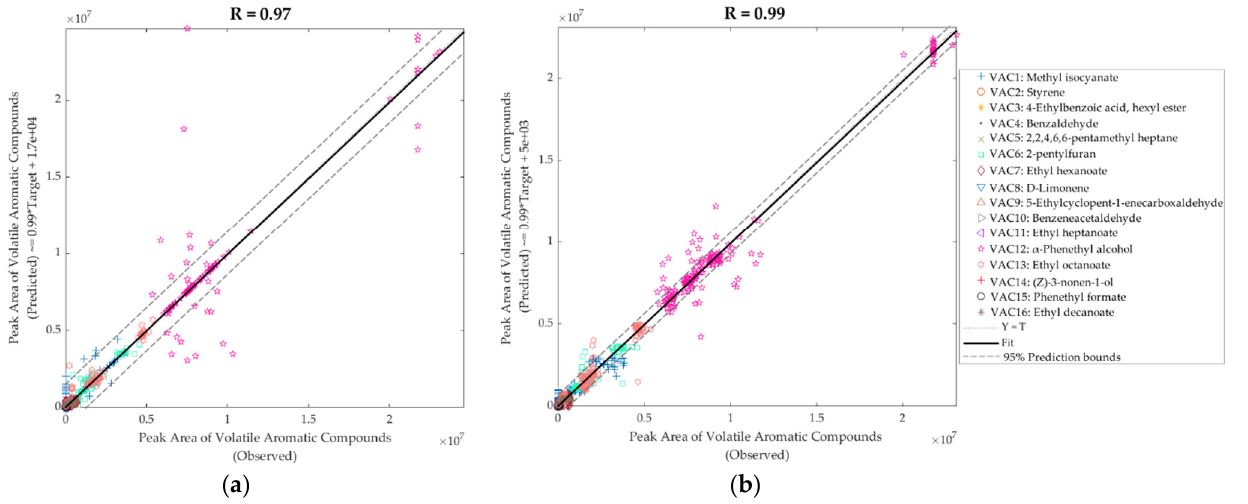
Figure 9. Overall Models 3 ( a ) and 4 ( b ) showing the data points of each target as well as the fitting line and 95% prediction bounds. Abbreviations: VAC: volatile aromatic compounds; T: targets; R: correlation coefficient.